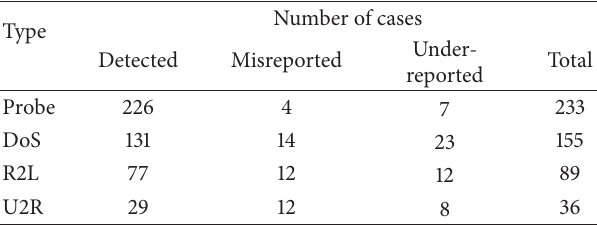
Table 4: Statistics based on intrusion type.